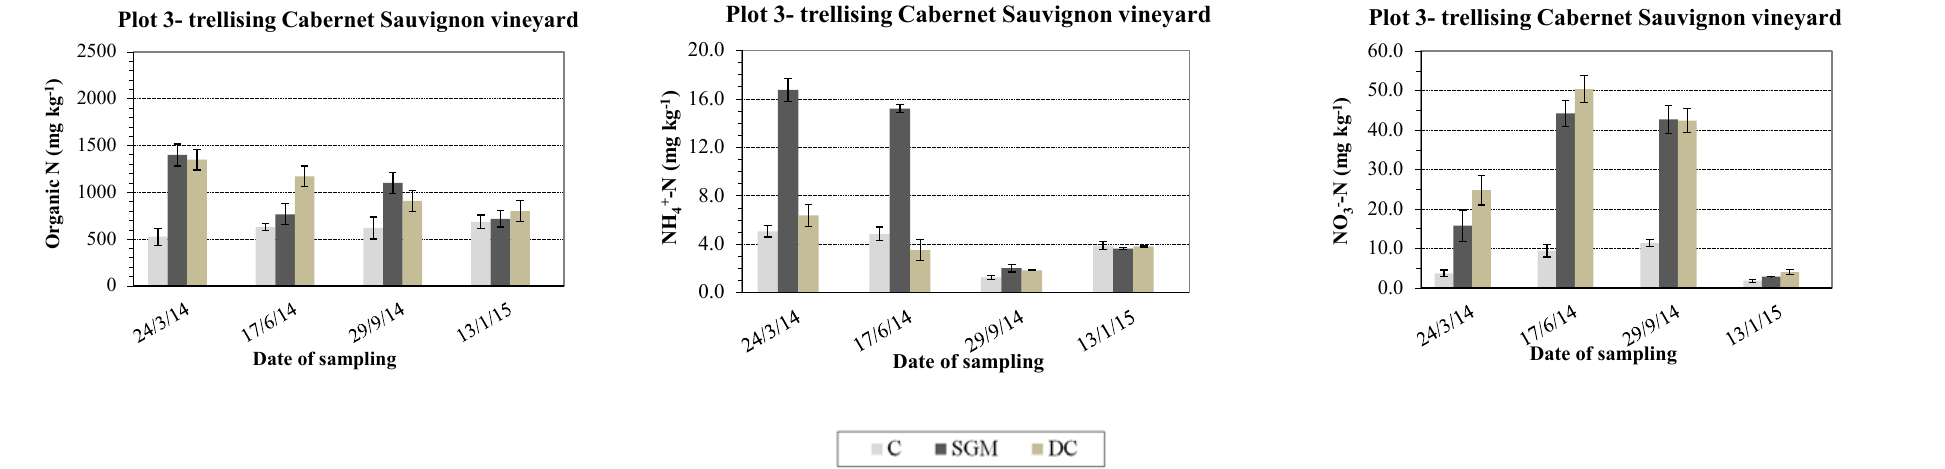
Figure 4. Changes over time in the organic nitrogen (organic N) ( A ), NH 4+ -N ( B ) and NO 3 − -N ( C ) contents. Error bars represent the standard error of the mean. (C: control, SGM: sheep/goat manure and DC: distillery organic waste compost).